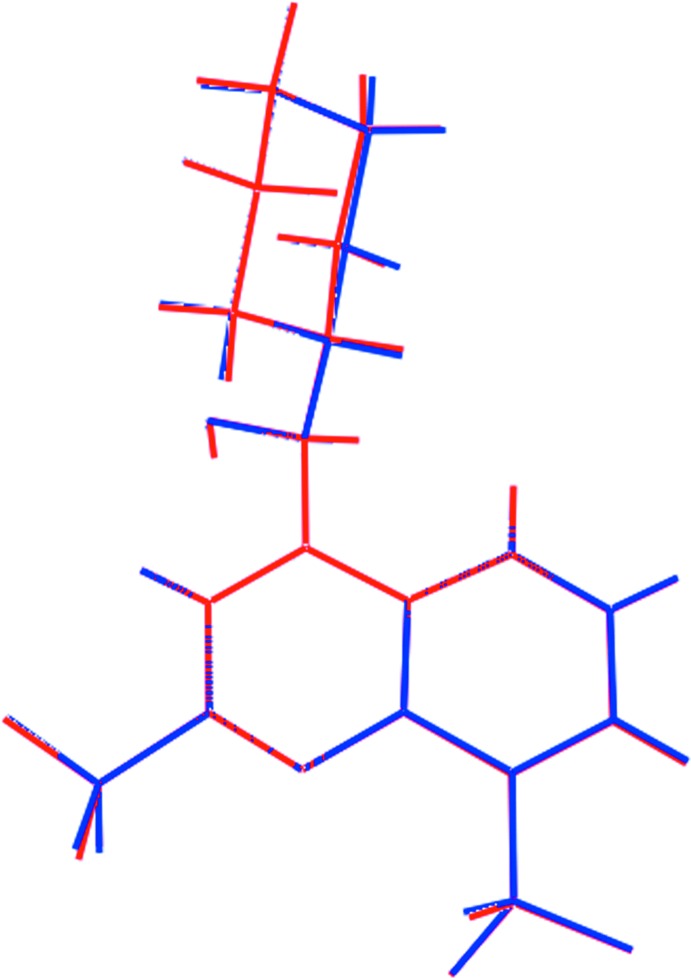
An overlay diagram of the N1- (red image) and N3-containing cations. The cations have been superimposed so that the C5N rings of the quinolinyl residues are coincident.